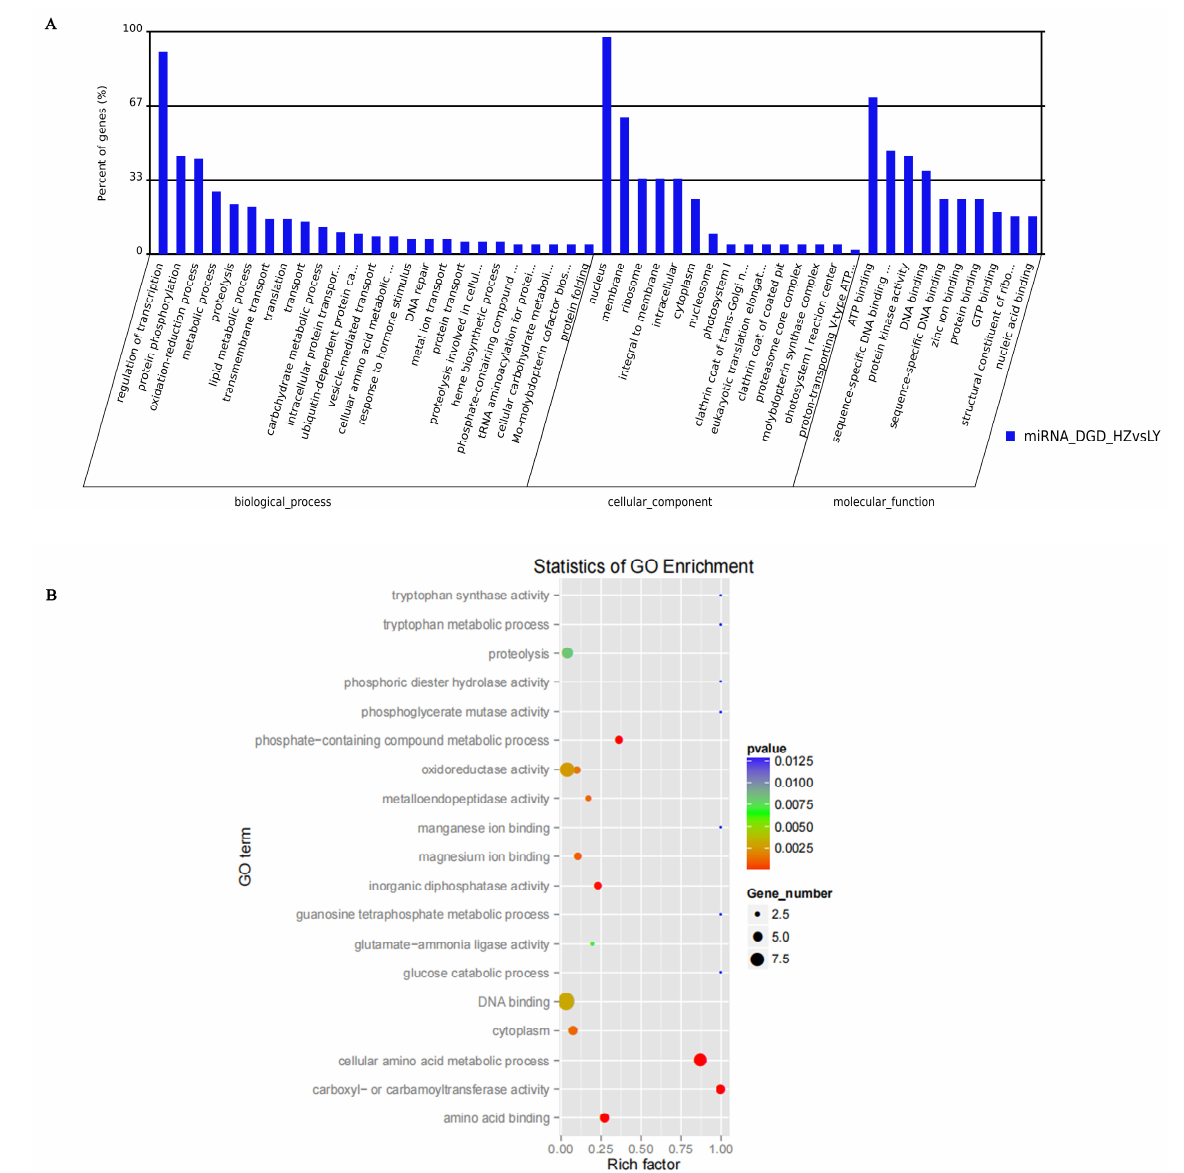
Figure 5. Function analysis of targets of miRNAs expressed differentially. ( A ) Functional clustering analysis of target genes of miRNAs expressed differentially significantly. ( B ) GO analysis of targets of miRNAs expressed differentially at different inoculation times by C. lunata .